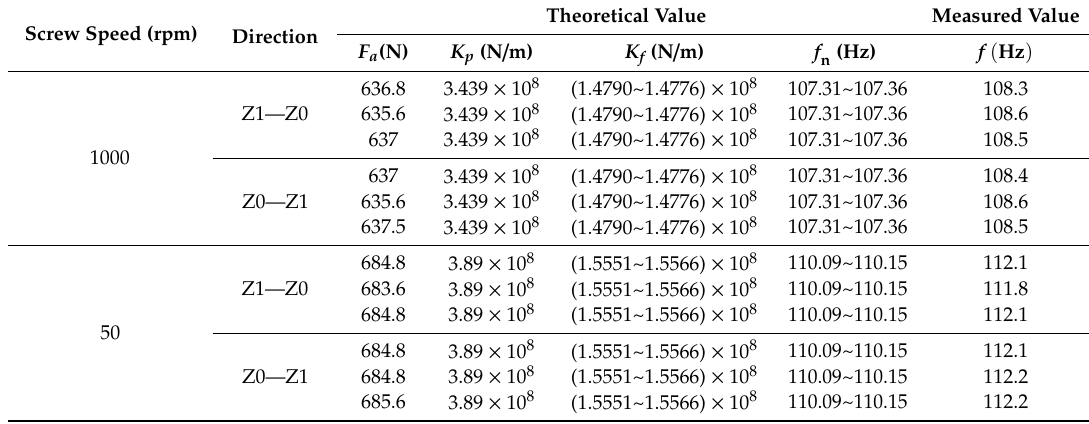
Table 3. Theoretical and test values of feed system dynamic